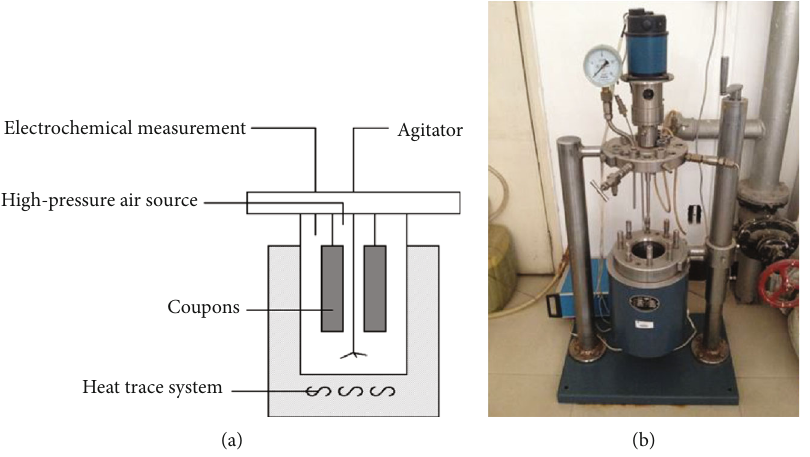
Figure 2: High pressure corrosion test reactor.